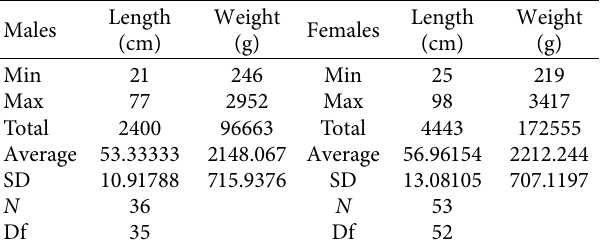
Table 1: Summary of length and weight parameters of H. niloticus .